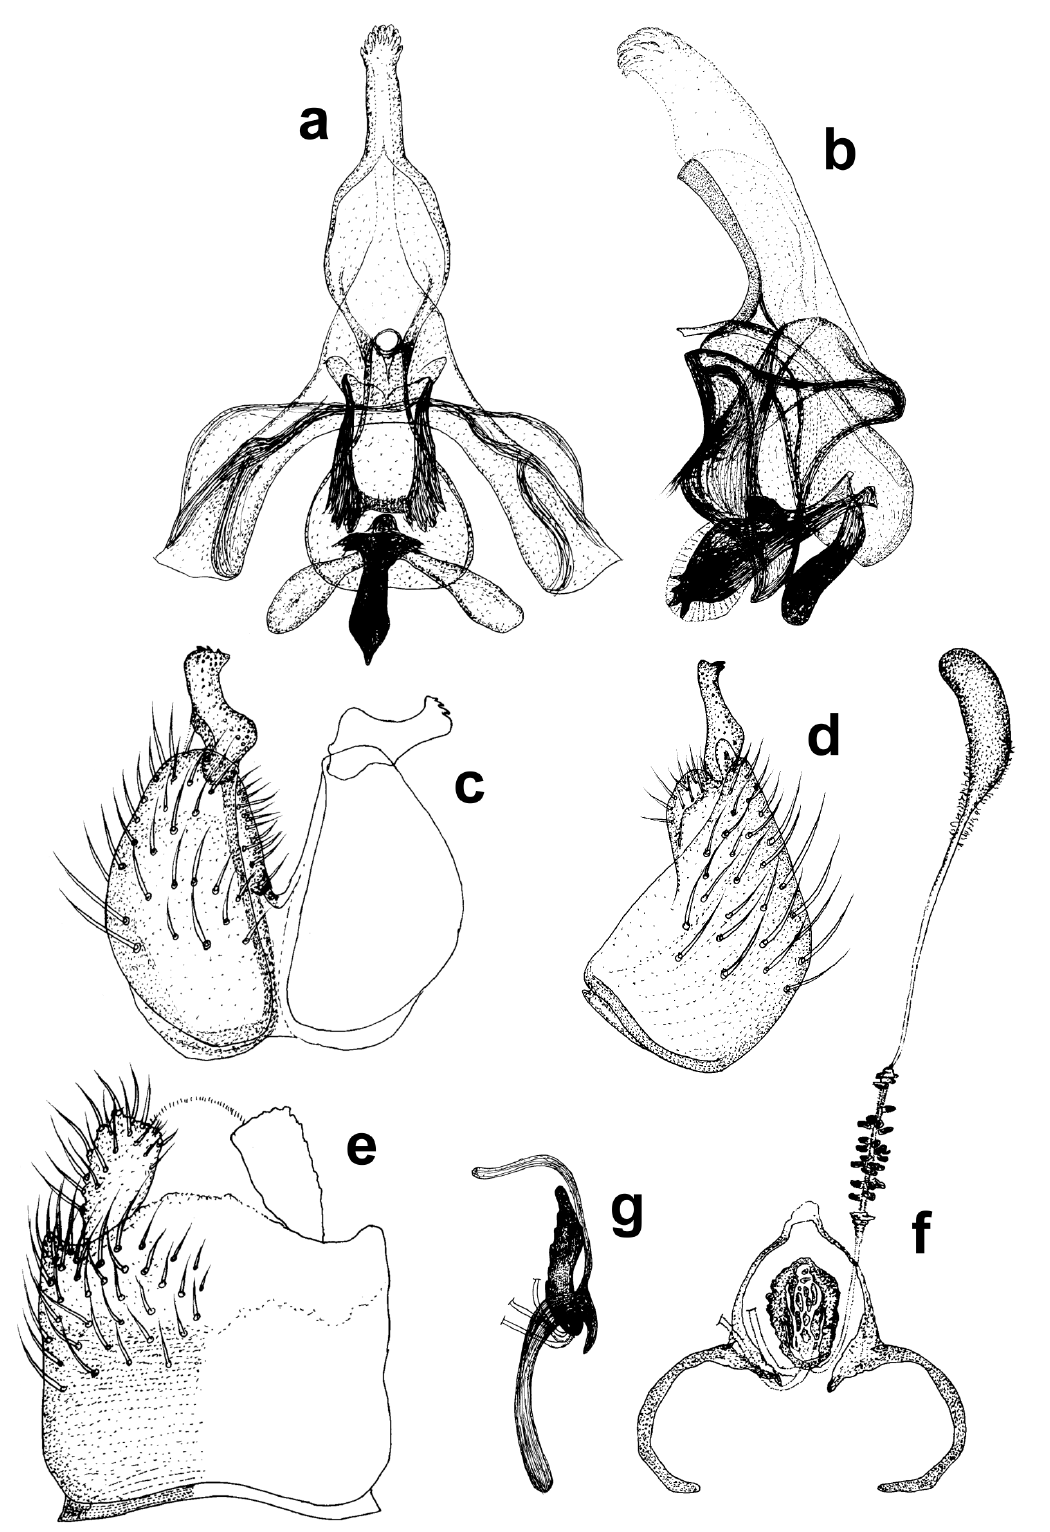
Fig. 45. Protypusia dimonica (Zaitzev, 1996) gen. et comb. nov. a . Epiphallic complex ventral. b . Epiphallic complex lateral. c . Gonocoxite ventral. d . Gonocoxite lateral. e . Epandrium dorsal. f . Female genitalia ventral. g . Female genitalia